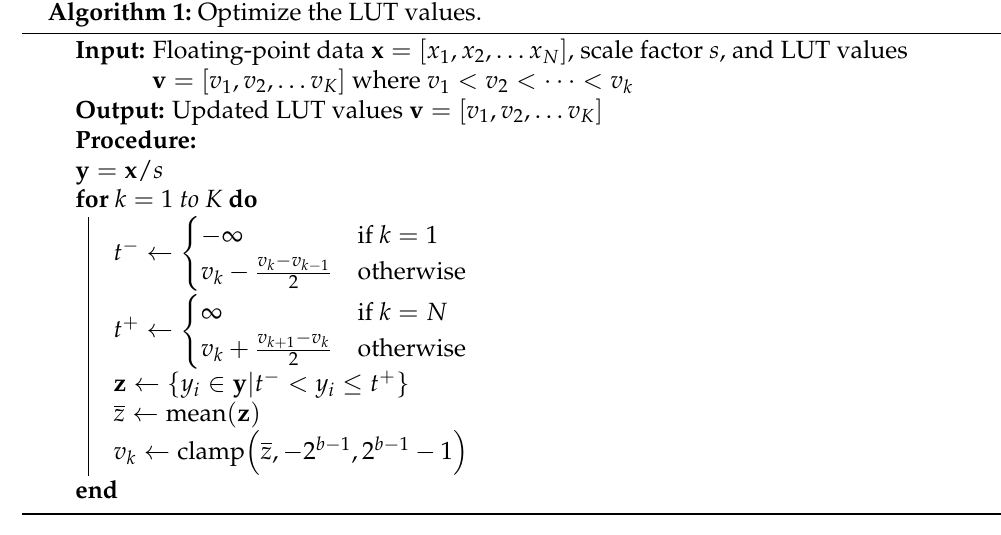
Algorithm 1: Optimize the LUT values.